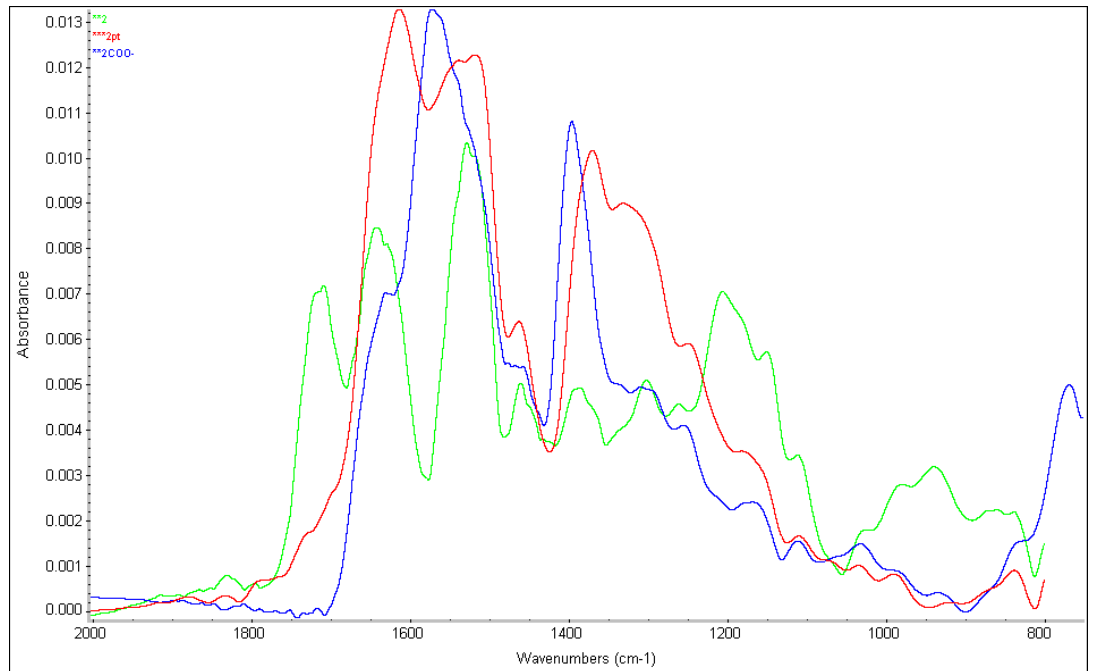
Figure 8. FT-IR spectra of the native hydrogel AVa-2 (COOH form, green line; COO- form, blue line) and coordinated to cisplatin (red